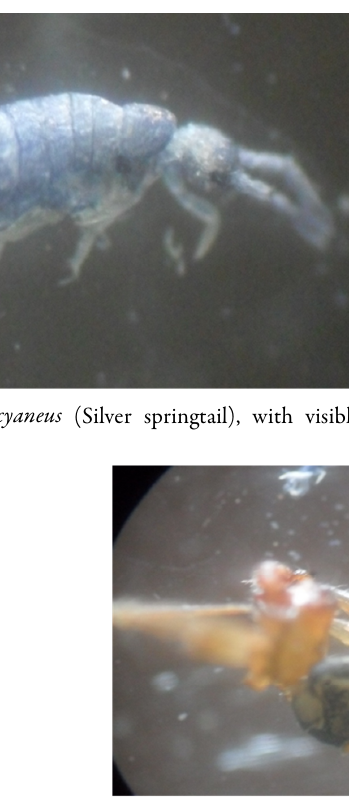
Fig. 9. Arachnida